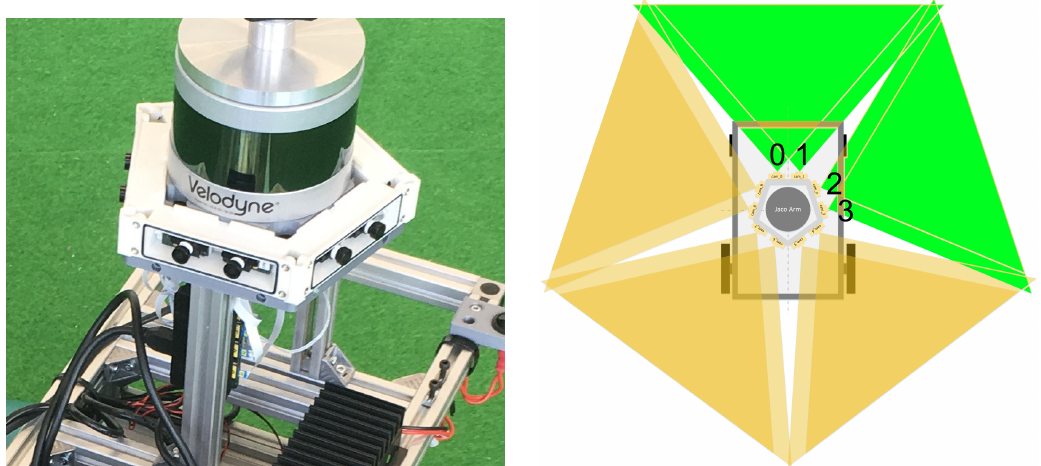
Figure A2. Trimbot Garden 2017 GT dataset [29]. ( Left ): Pentagonal camera rig mounted on the robot with five stereo pairs. ( Right ): Top view of camera rig with test set pairs (green field of veiw) and training set pairs (yellow field of